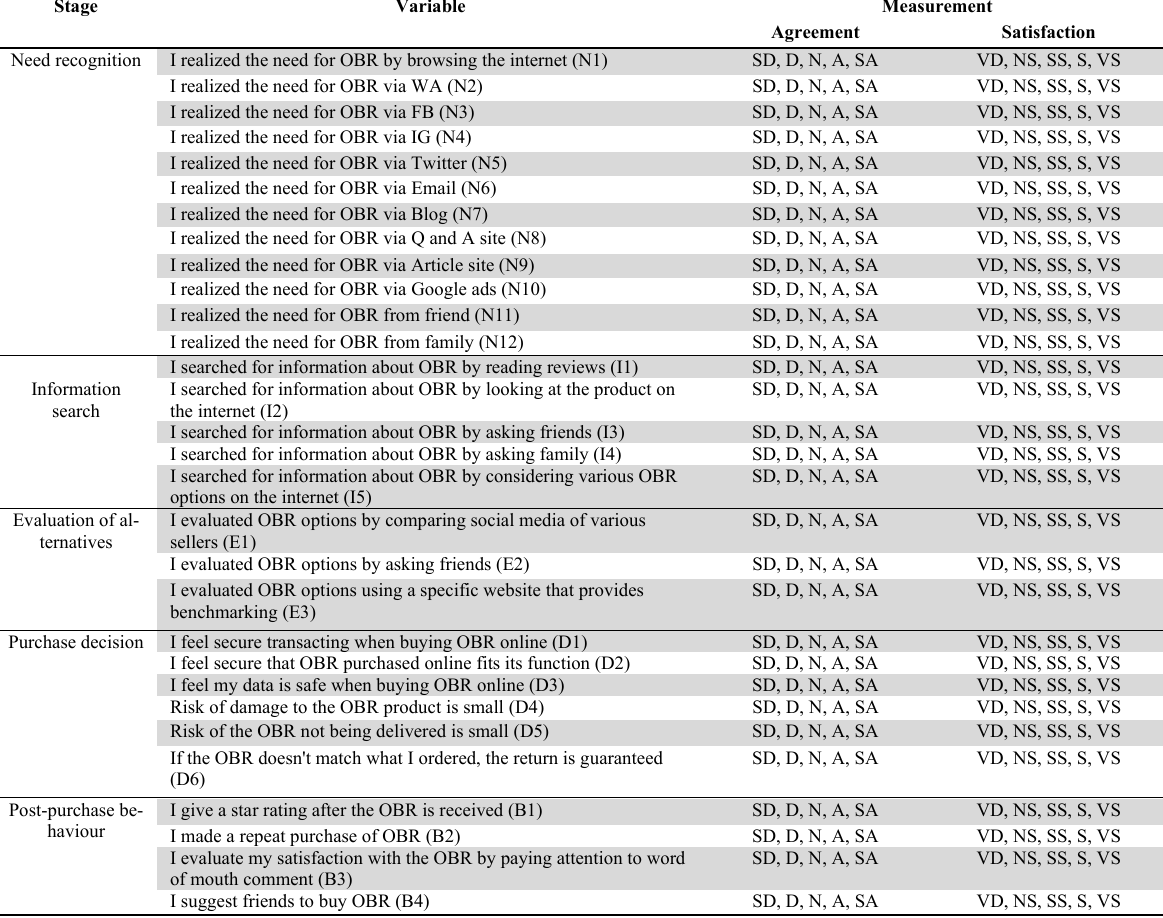
Variable and Measurement of OBR Online Purchase Decision Process via S-commerce and the Satisfaction Stage Variable Measurement Agreement